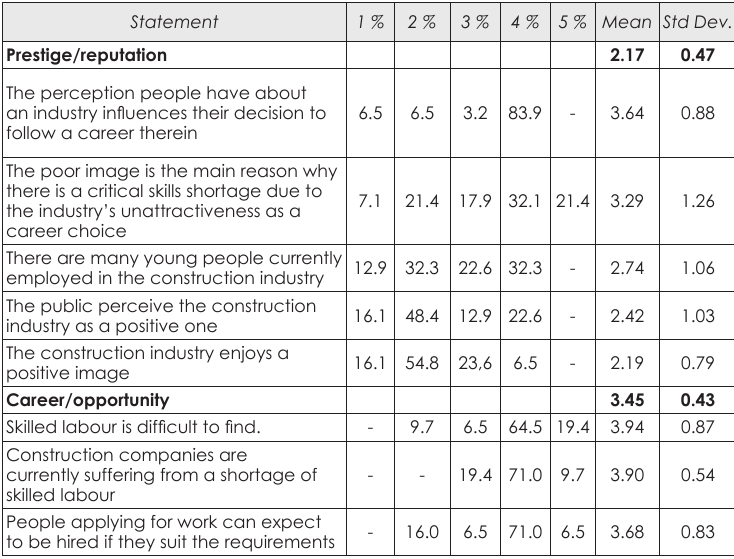
Table 13: Perceptions of employers (n=31)